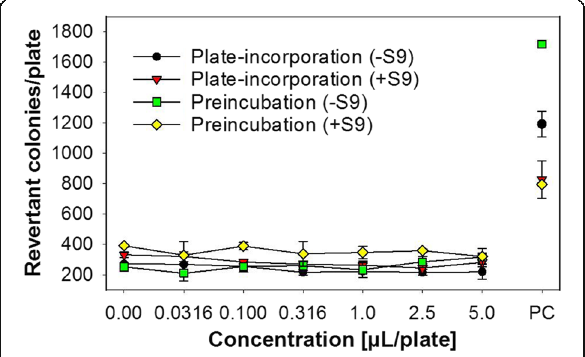
Fig. 3 Results from Ames tests on HNE . Data from tester strain S. typhimurium TA102 are exemplarily presented. PC = positive